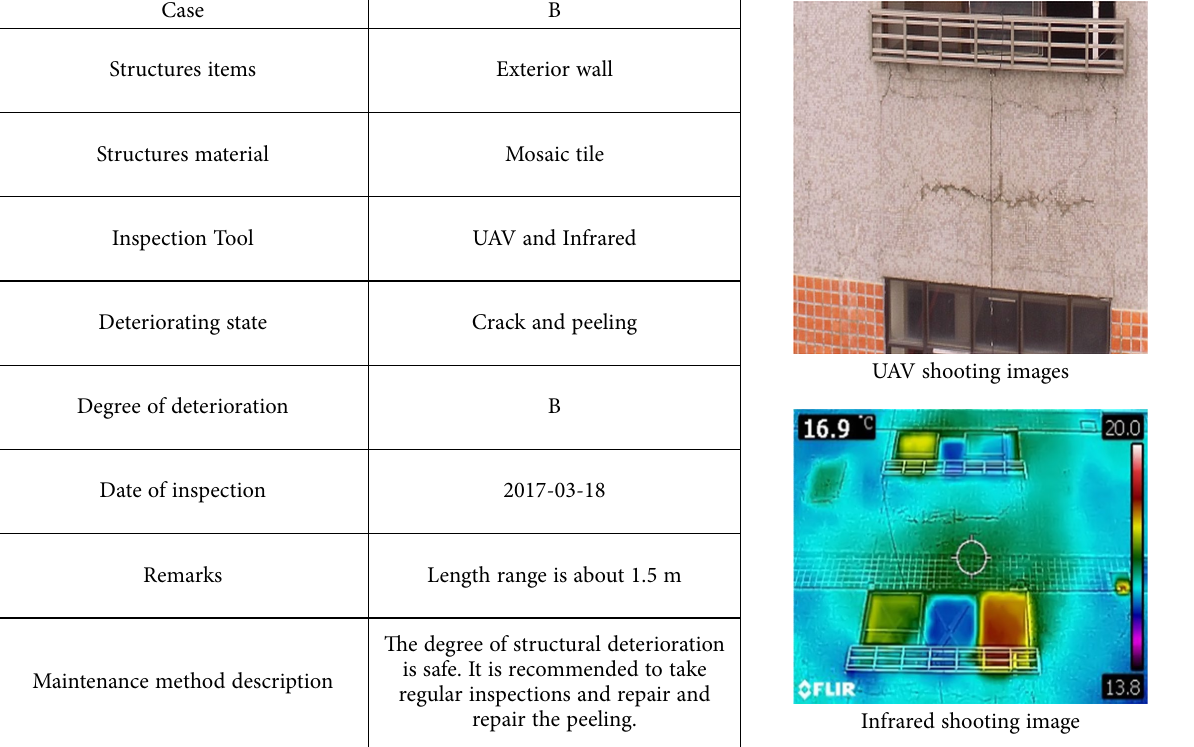
Figure 13. The web interface output of the case